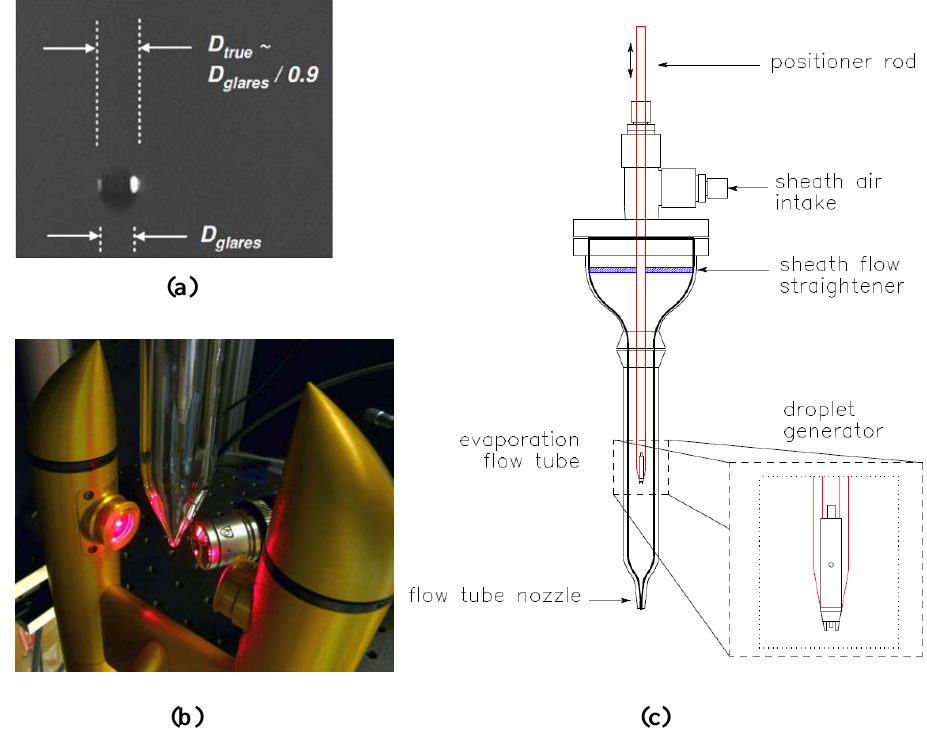
Fig. 2. (a) Photograph of a single droplet in the sample area of the CDP, seen at an angle of 121 ◦ from incident, using a shutter speed of 1/300000s − 1 , (b) Photograph of the evaporation flow-tube positioned above the sample area of the CDP during calibration with water droplets, and (c) diagram of the glass evaporation flow-tube used for the water droplet calibrations of the